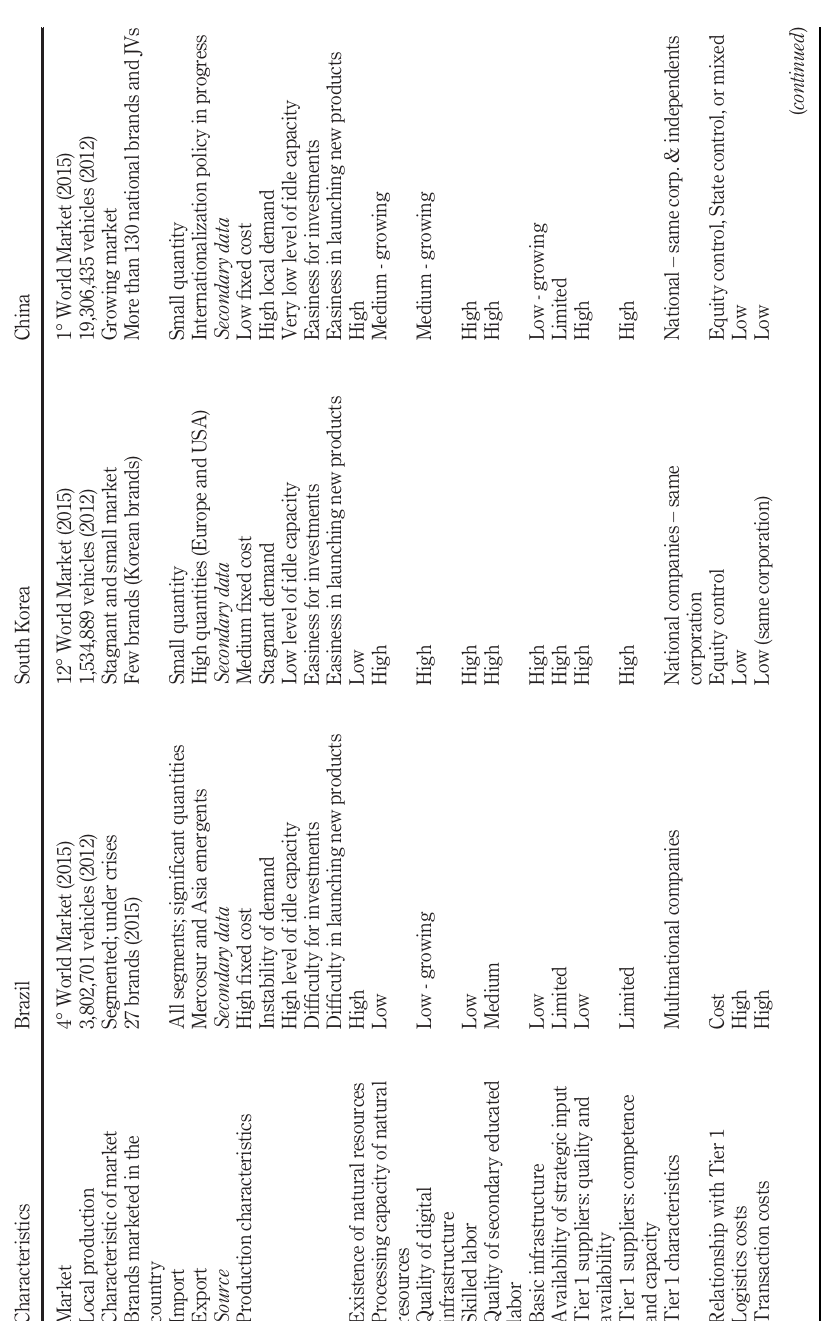
Table III. Summary of research